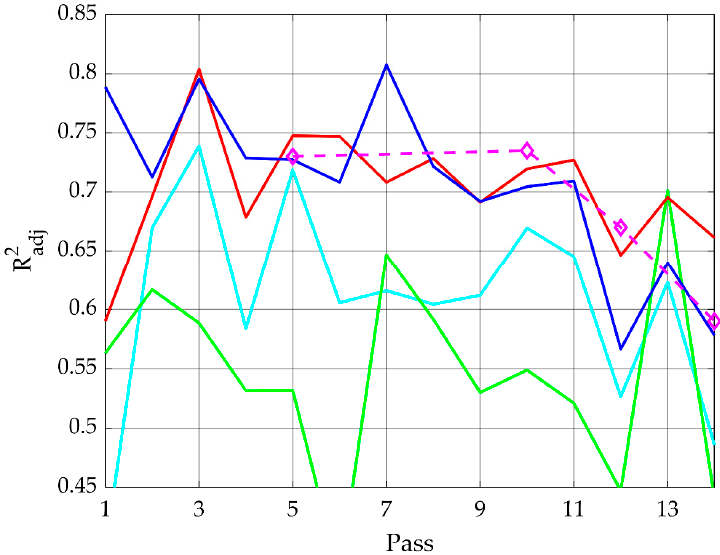
Figure 14. The R adj 2 obtained from models B = B 0 + µ ρ H (cyan), B = c 0 R 0 + c 1 R 1 (green), B = c 0 H + c 1 R 1 (red), and B = c 0 H + c 1 R 1 + c 2 R 2 (blue) for the 14 passes from Transect 3. Passes 1 and 2 were at 5 km h − 1 , passes 3 to 8 at 10 km h − 1 , passes 9 to 11 at 15 km h − 1 , and passes 12 to 14 at 20 km h − 1 . Remote Sens. 2019 , 11 , x FOR PEER REVIEW Also shown are the model B = c 0 H + c 1 R 1 results from Transect 2 (magenta diamonds, dashed line).